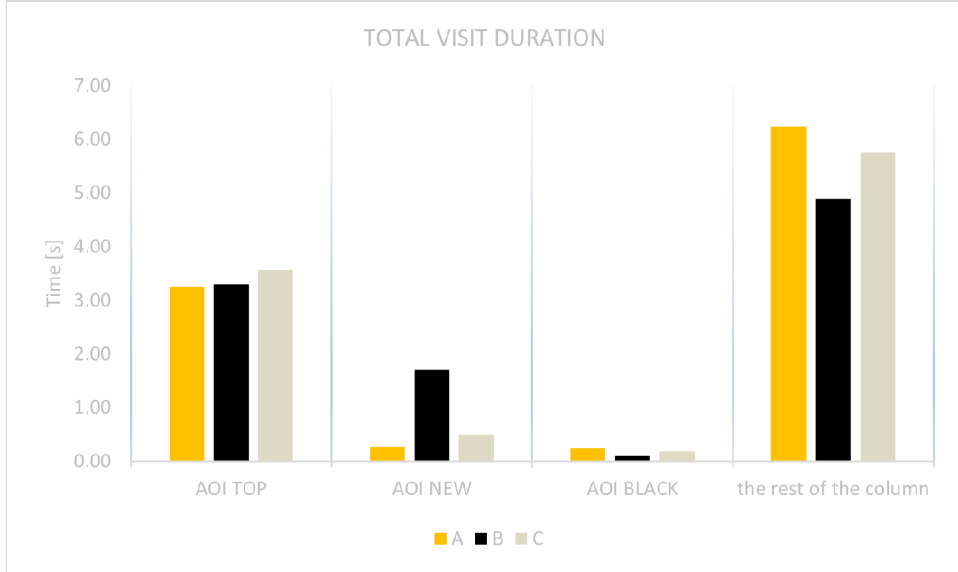
Figure 7. Comparison of total visit duration (TVD) for different AOIs.